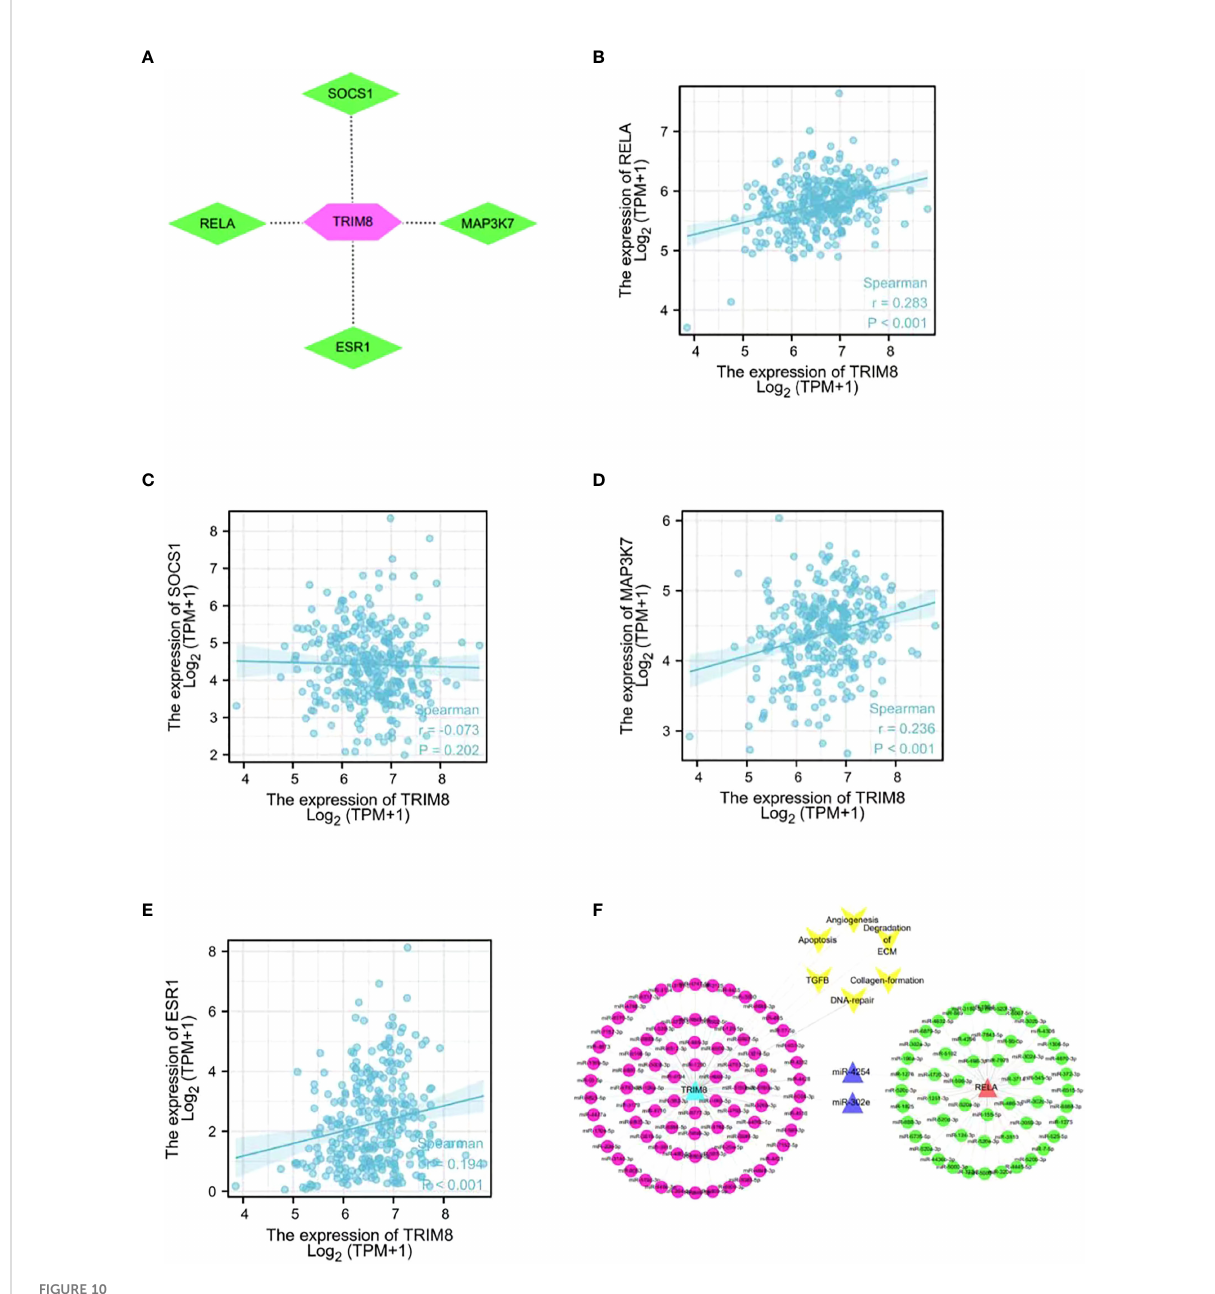
FIGURE 10 Network and function of TRIM8 and its substrate genes. (A) Network view of predicted E3-substrate interactions in UbiBrowser web services. In network view, the central node is TRIM8, and the surrounding nodes are the predicted substrates. (B – E) Correlation analysis of TRIM8 and four predictive substrates in cervical cancer. (F) Schematic diagram of interaction of co-expressed miRNA network of TRIM8 and